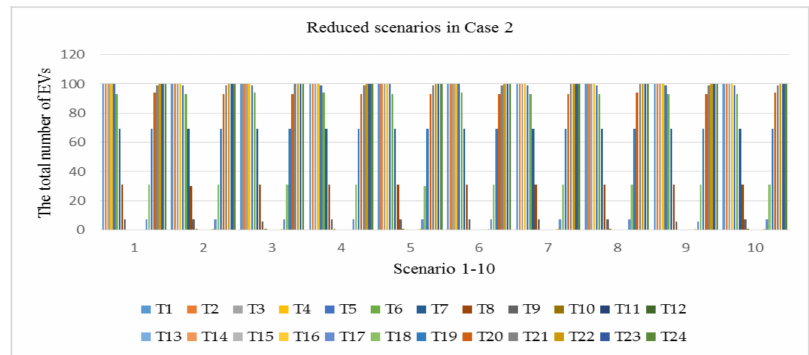
Figure 13. The number of available EVs for reduced scenarios in Case 2.